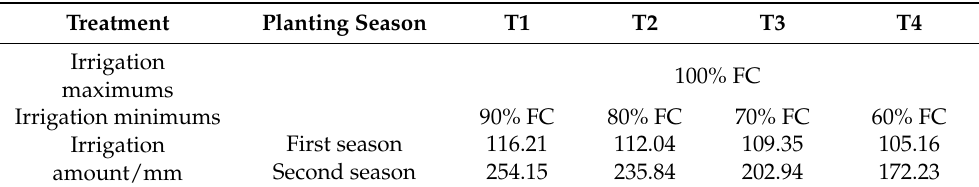
Table 1. Irrigation treatment design.